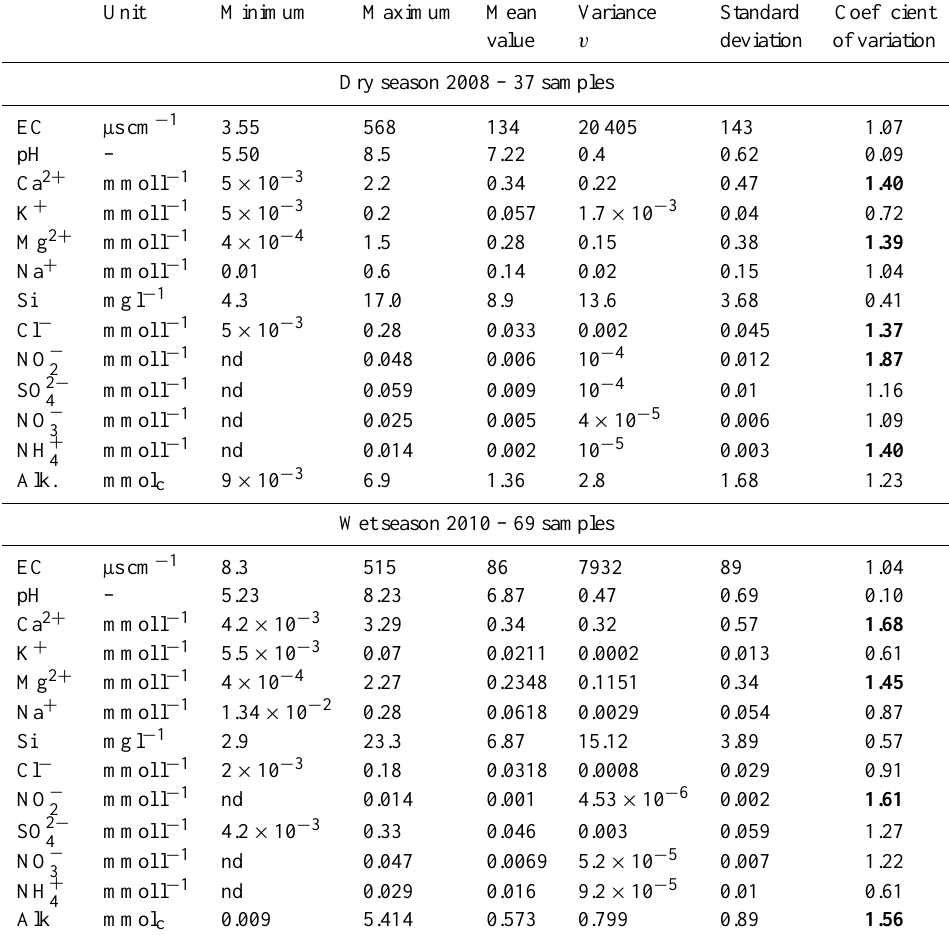
Table 2. Descriptive statistics of major elements in sampling DS (dry season 2008) and WS (wet season 2010). Unit Minimum